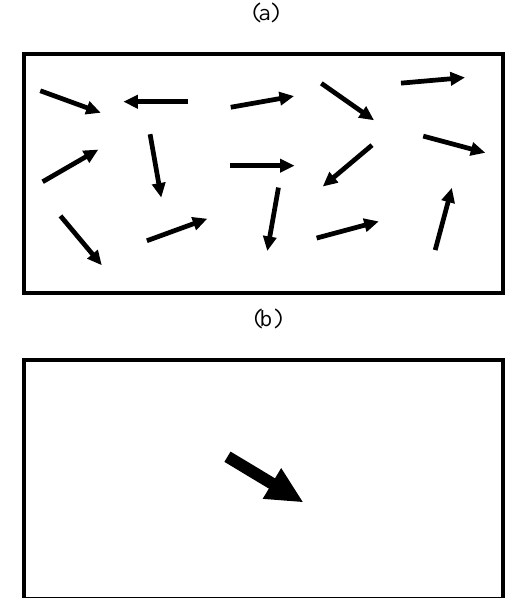
Fig. 1. (a) A sketch figure of the crystals in the rock with a weak preferred orientation. The thin bold arrow indicates the orientation of each crystal. (b) An equivalent orientation of crystals in the rock, which is the same as that given in (a) . The thick bold arrow gives the equivalent orientation of crystals in (a).